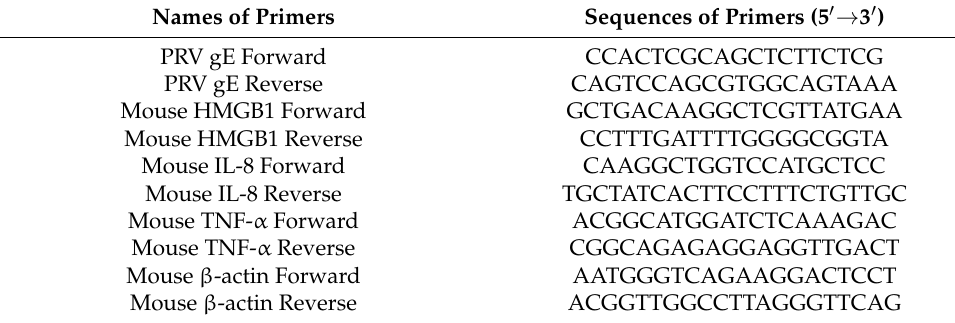
Table 1. Primer used for RT-PCR and qRT-PCR. Names of